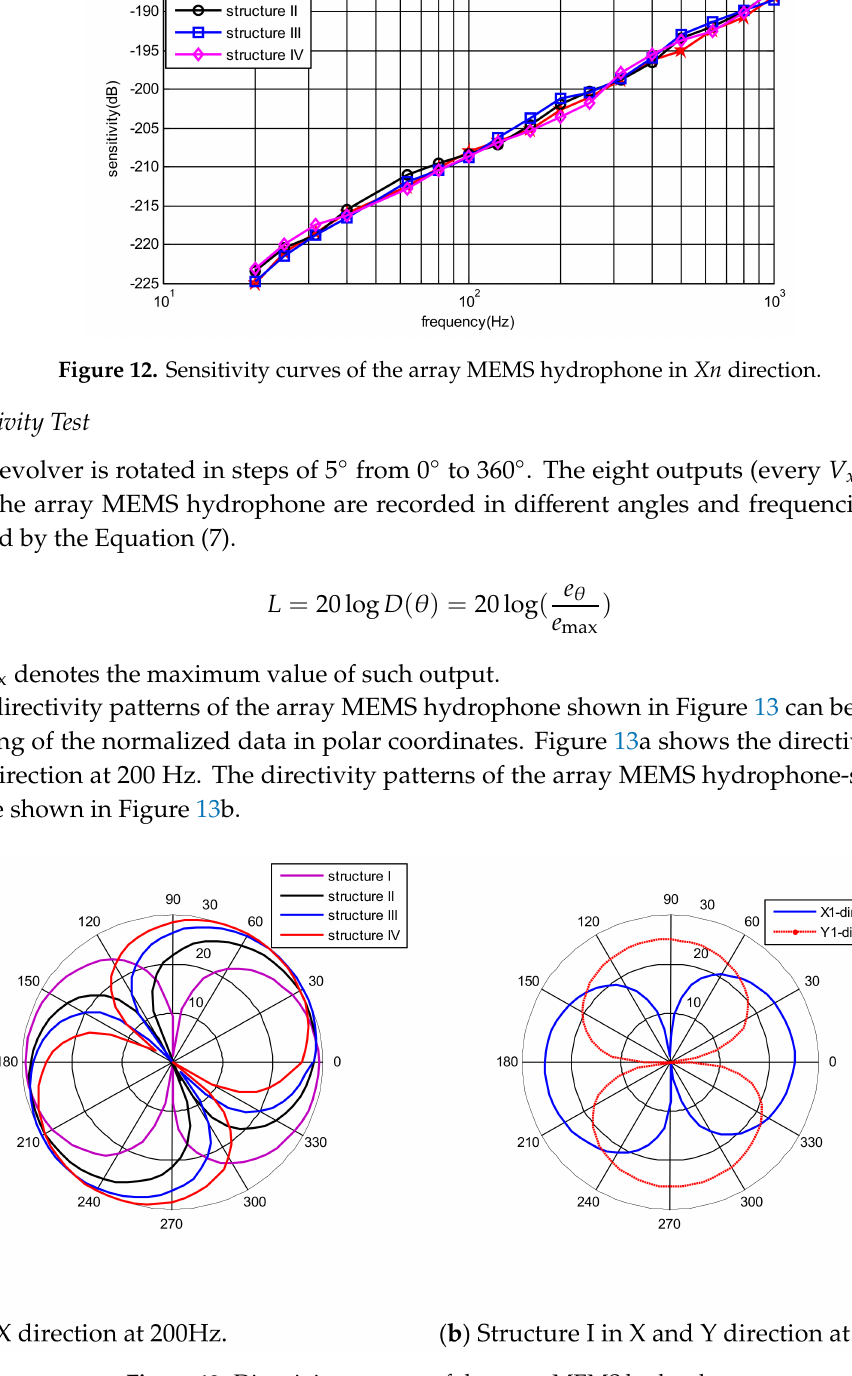
Figure 13. Directivity patterns of the array MEMS